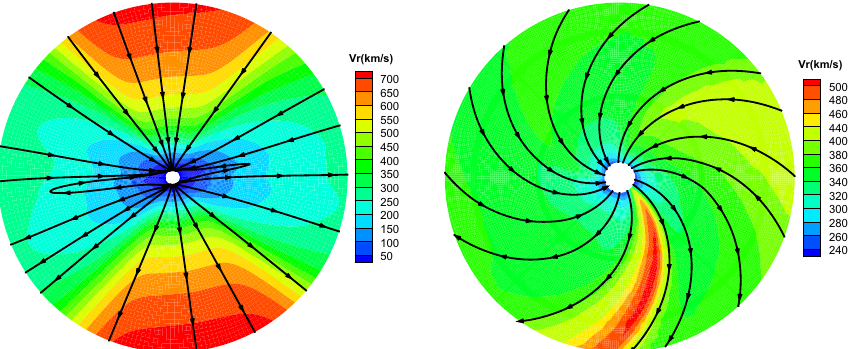
Fig. 1. Magnetic fi eld and radial speed v r (km/s) for the steady state solar wind solution. The left is on the meridional plane of / = 180 (cid:3) (cid:4) 0 (cid:3) from 1 R s to 20 R s , the right is on the equatorial plane from 20 R s to 220 R s . The color contours represent the radial speed and streamlines denote the magnetic fi eld